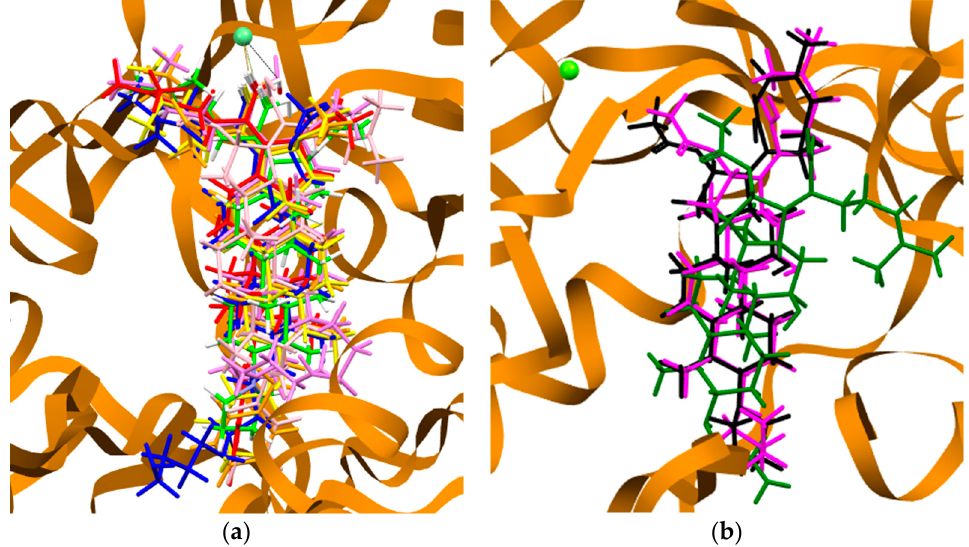
Figure 6. Complex of EF-G with ligands: ( a ) 3 (red), 5 (yellow), 7 (light green), 9 (pink), 17 (orange), 19 (blue), and 21 (violet); ( b ) 11 (green), 13 (magenta), and 15